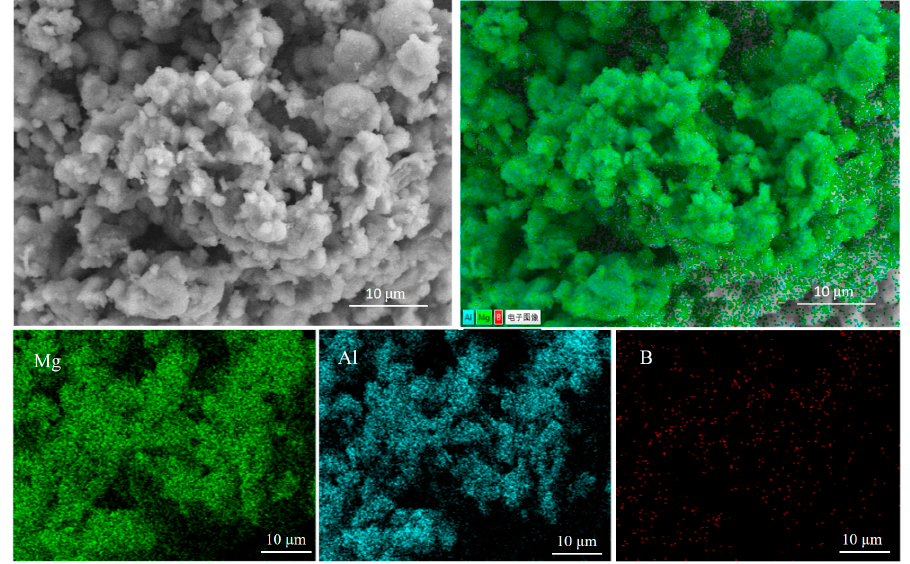
Figure 5. SEM tests on the amorphous boron-decorated Al 3 Mg 2 alloy.